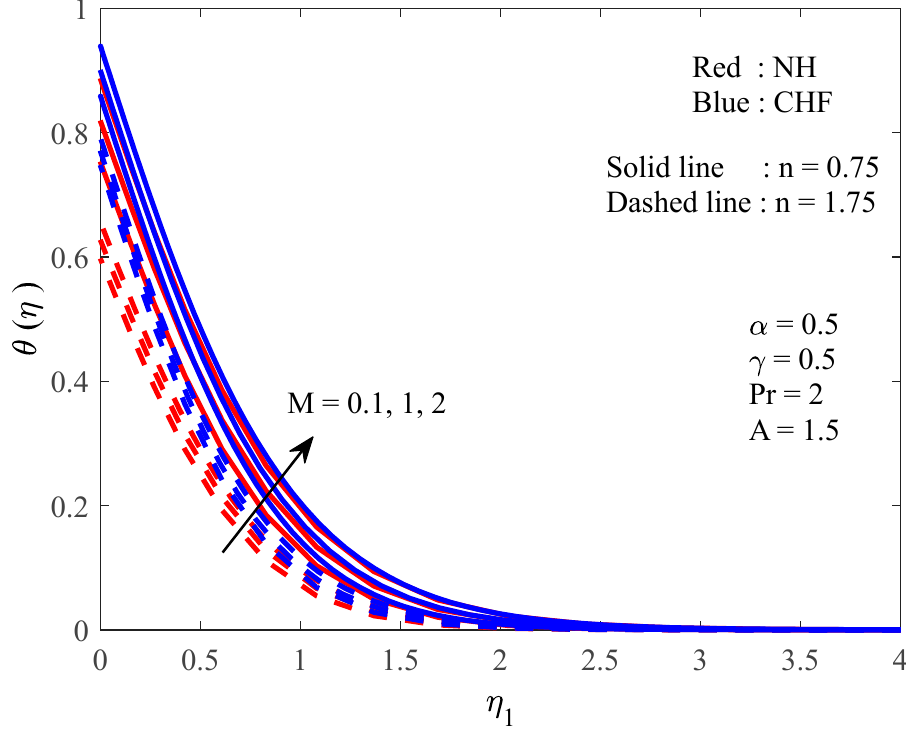
Figure 3. The temperature distribution profile with the influence of M .